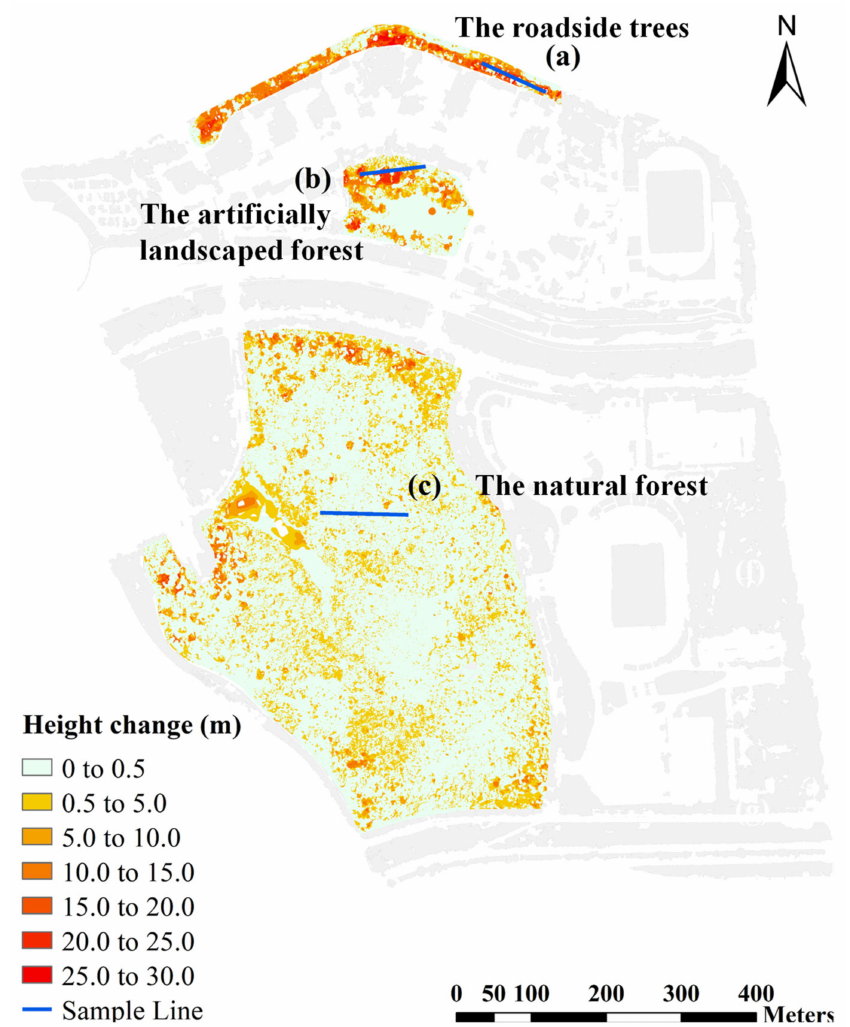
Figure 4. Distribution of urban vegetation canopy height changes in the study area (GSD: 10 cm). ( a ) The roadside trees; ( b ) the artificially landscaped forest; and ( c ) the natural